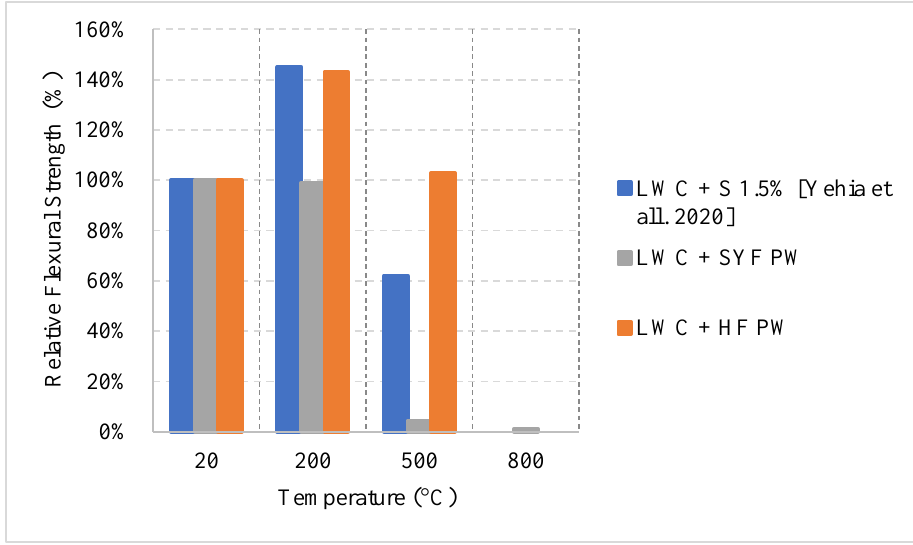
Figure 22. Spalled samples after temperature loading with 800 °C. 2.4.2. Natural Cooling inside the Furnace Another unique type of fibers are hemp fibers. These fibers are extracted from plants and can be integrated into the mix design to enhance the post-fire performance of concrete. Using PP or hemp fibers can increase the compressive strength by about 12%. This could be attributed to the increased bond present at lower temperatures before the disintegra- tion of the fibers. With this type of fiber, the concrete did not benefit from the channel